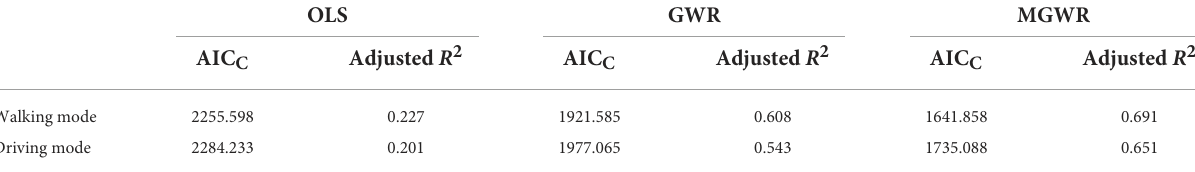
TABLE 4 Comparison of goodness of fit of OLS, GWR, and MGWR